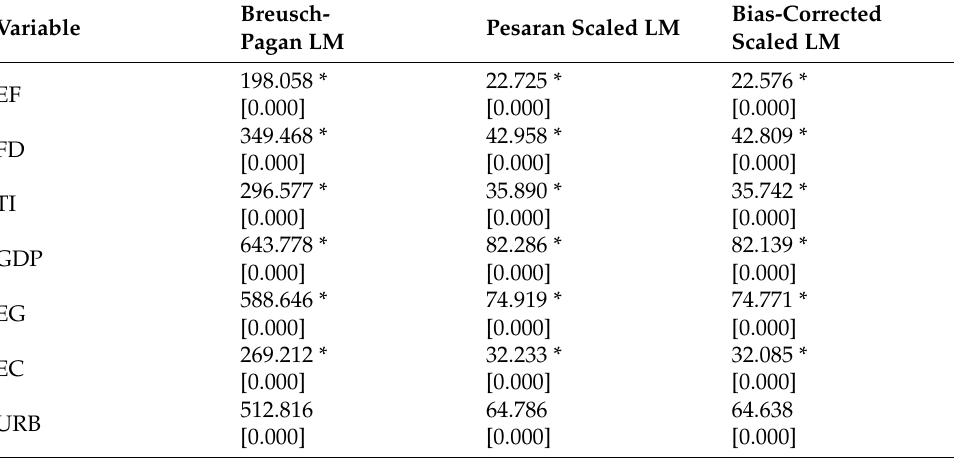
Table 2. CD test results.